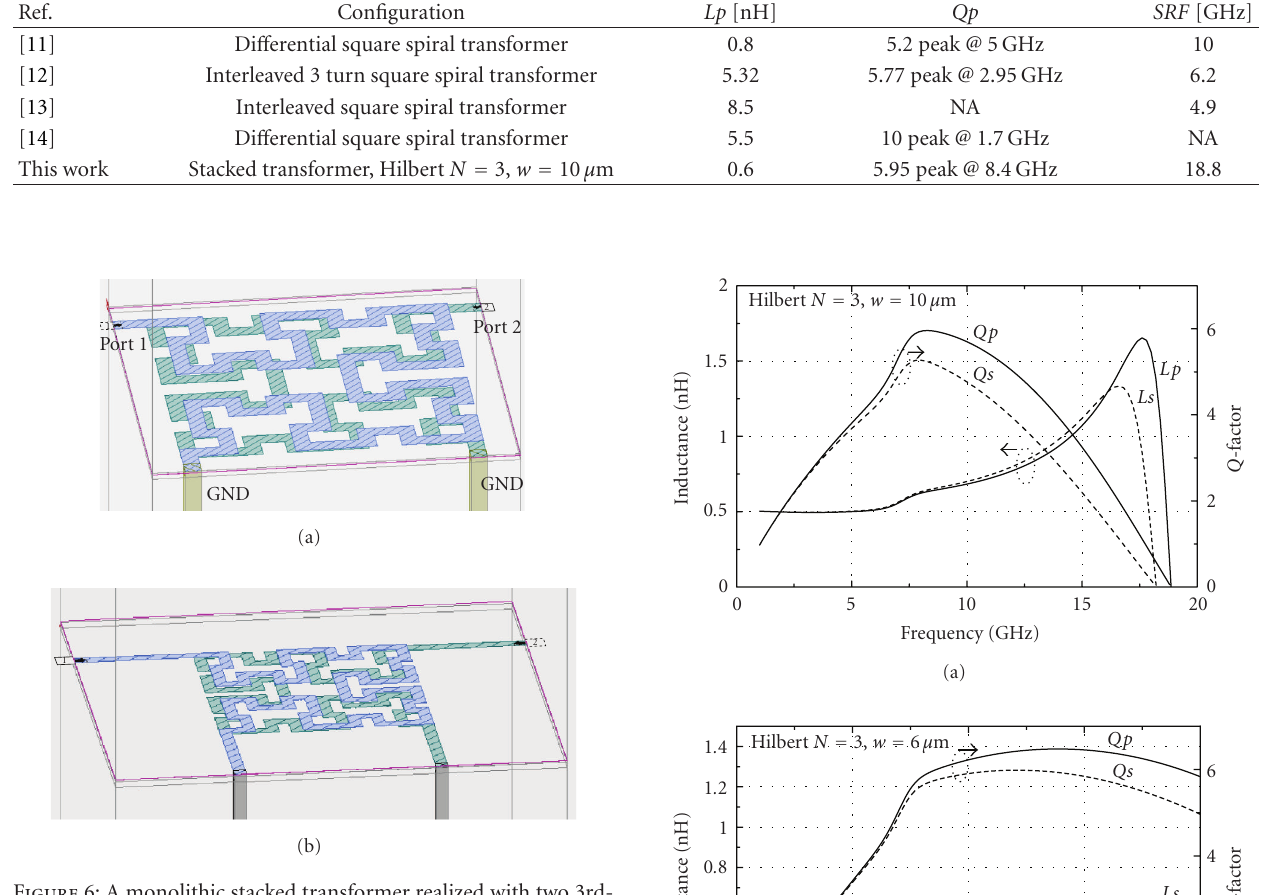
Figure 6: A monolithic stacked transformer realized with two 3rd- order Hilbert curve, (a) w p = w s = 10 μ m, (b) w p = w s = 6 μ m.